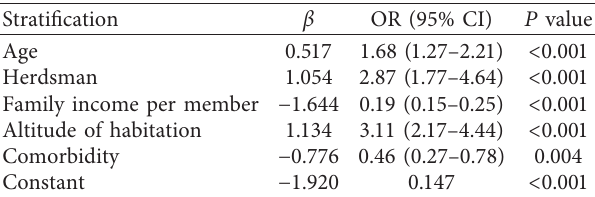
Table 2: Prediction factors for nontreatment in hypertension from study population by multiple logistic regression